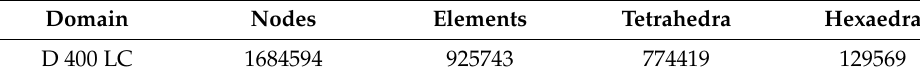
Figure 4. Computational domain mesh with refinement cones. Table 1. Data for the considered mesh with refinement cones.